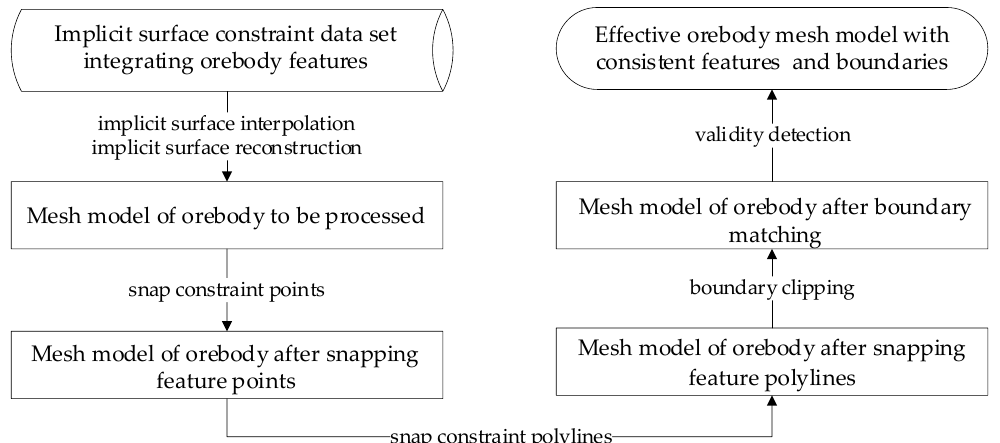
Figure 1. Reasons for inaccurate snapping in implicit surface reconstruction. ( a , b ) show the two different surface reconstruction results caused by ambiguity in the vertex state of the same voxel unit. ( c , d ) show the phenomenon of the loss of features after surface reconstruction due to the de- fects of the iso-surface extraction algorithm. ( e ) shows an example of implicit surface reconstruction of an orebody based on borehole constraints.